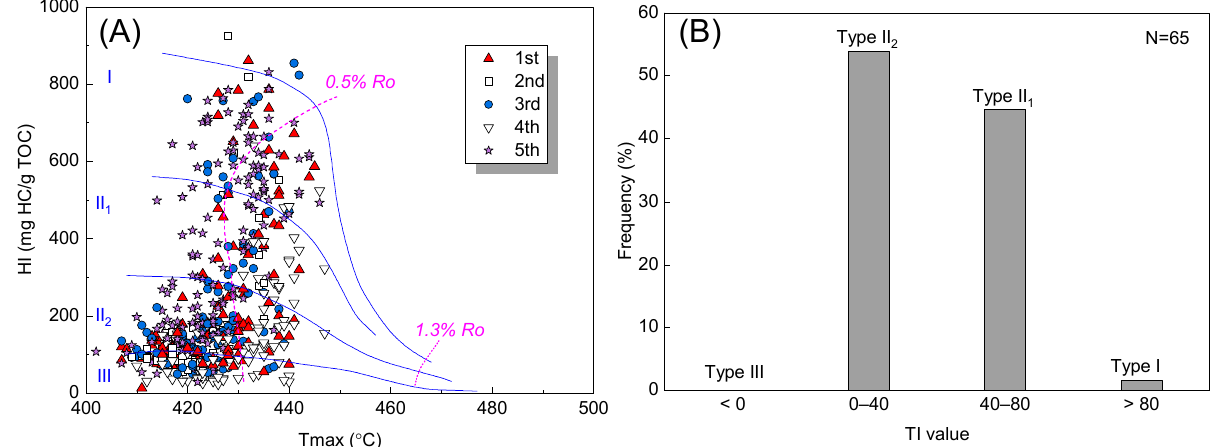
Figure 7. Cross-plot of S1 + S2 vs. TOC (after [37]).